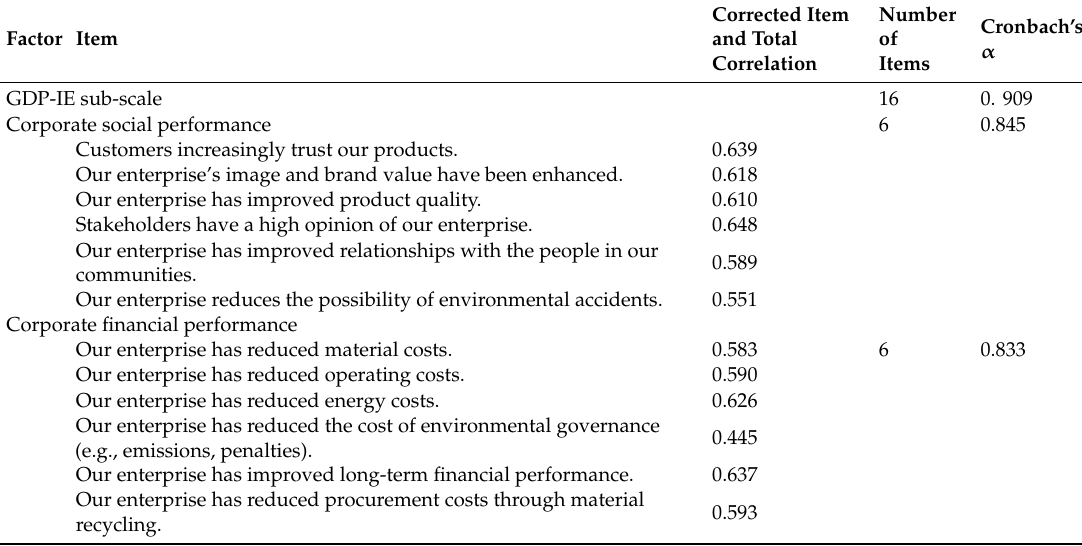
Table 11. Test results of the GDP-IE sub-scale ( N =